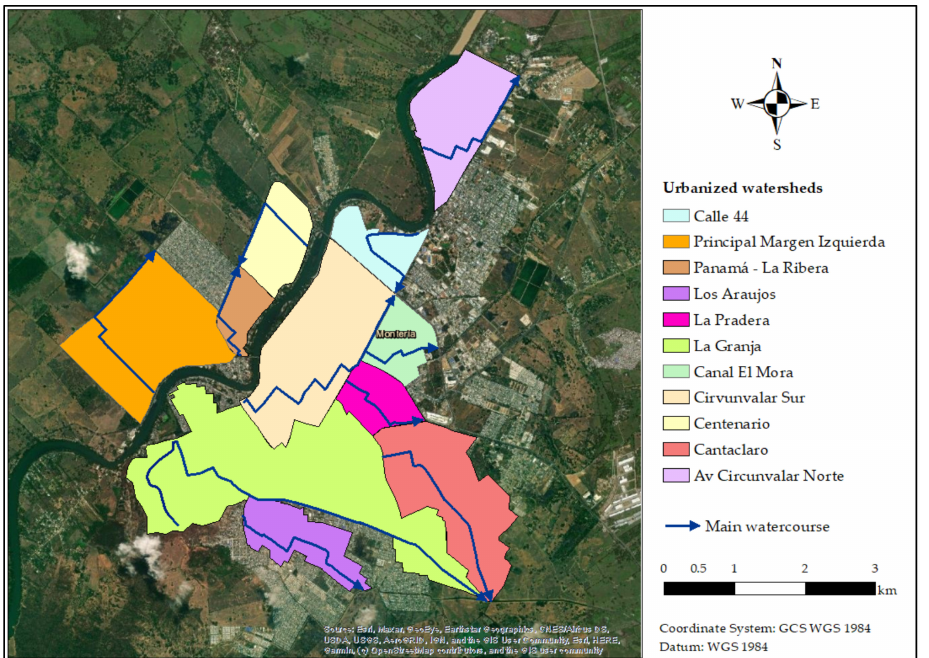
Figure 4. Selected small urban watersheds and main watercourses.